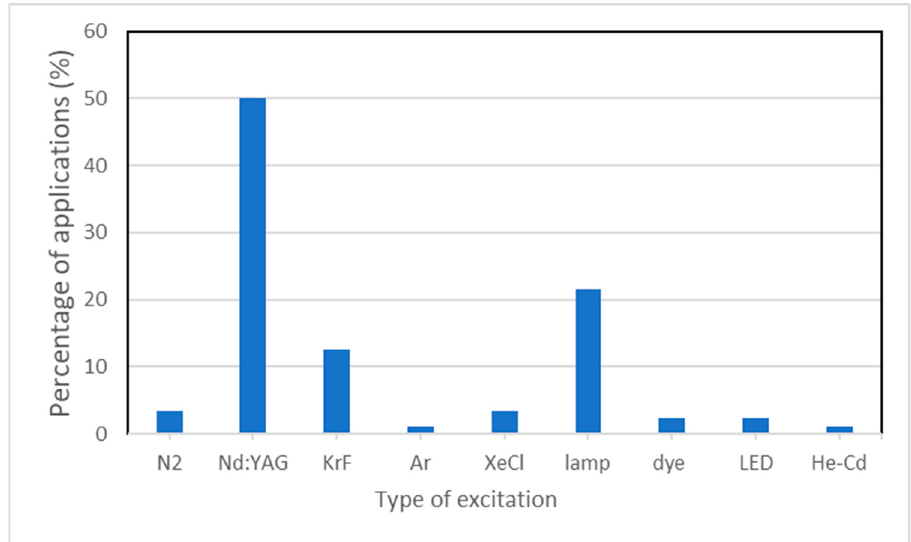
Figure 4. Type of excitation used in fluorescence studies.